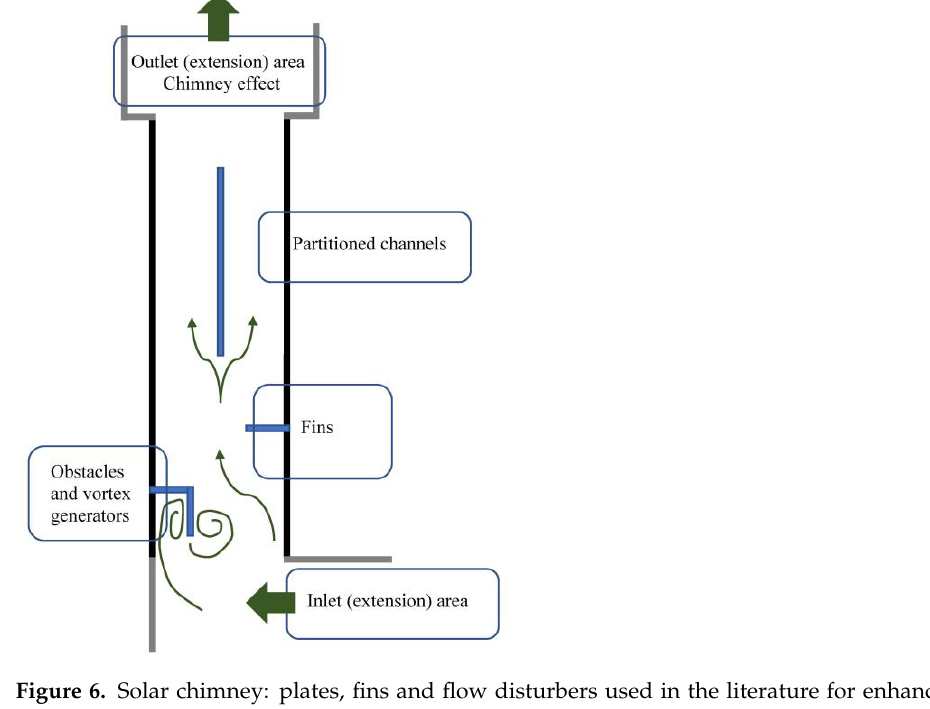
Figure 6. Solar chimney: plates, fins and flow disturbers used in the literature for enhancement behavior proposals.